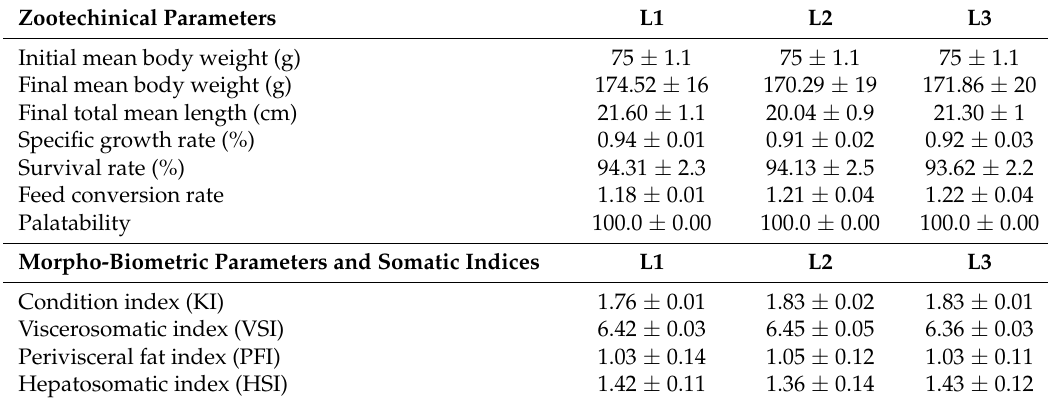
Table 5. Growth performances of gilthead sea bream that were fed the three different